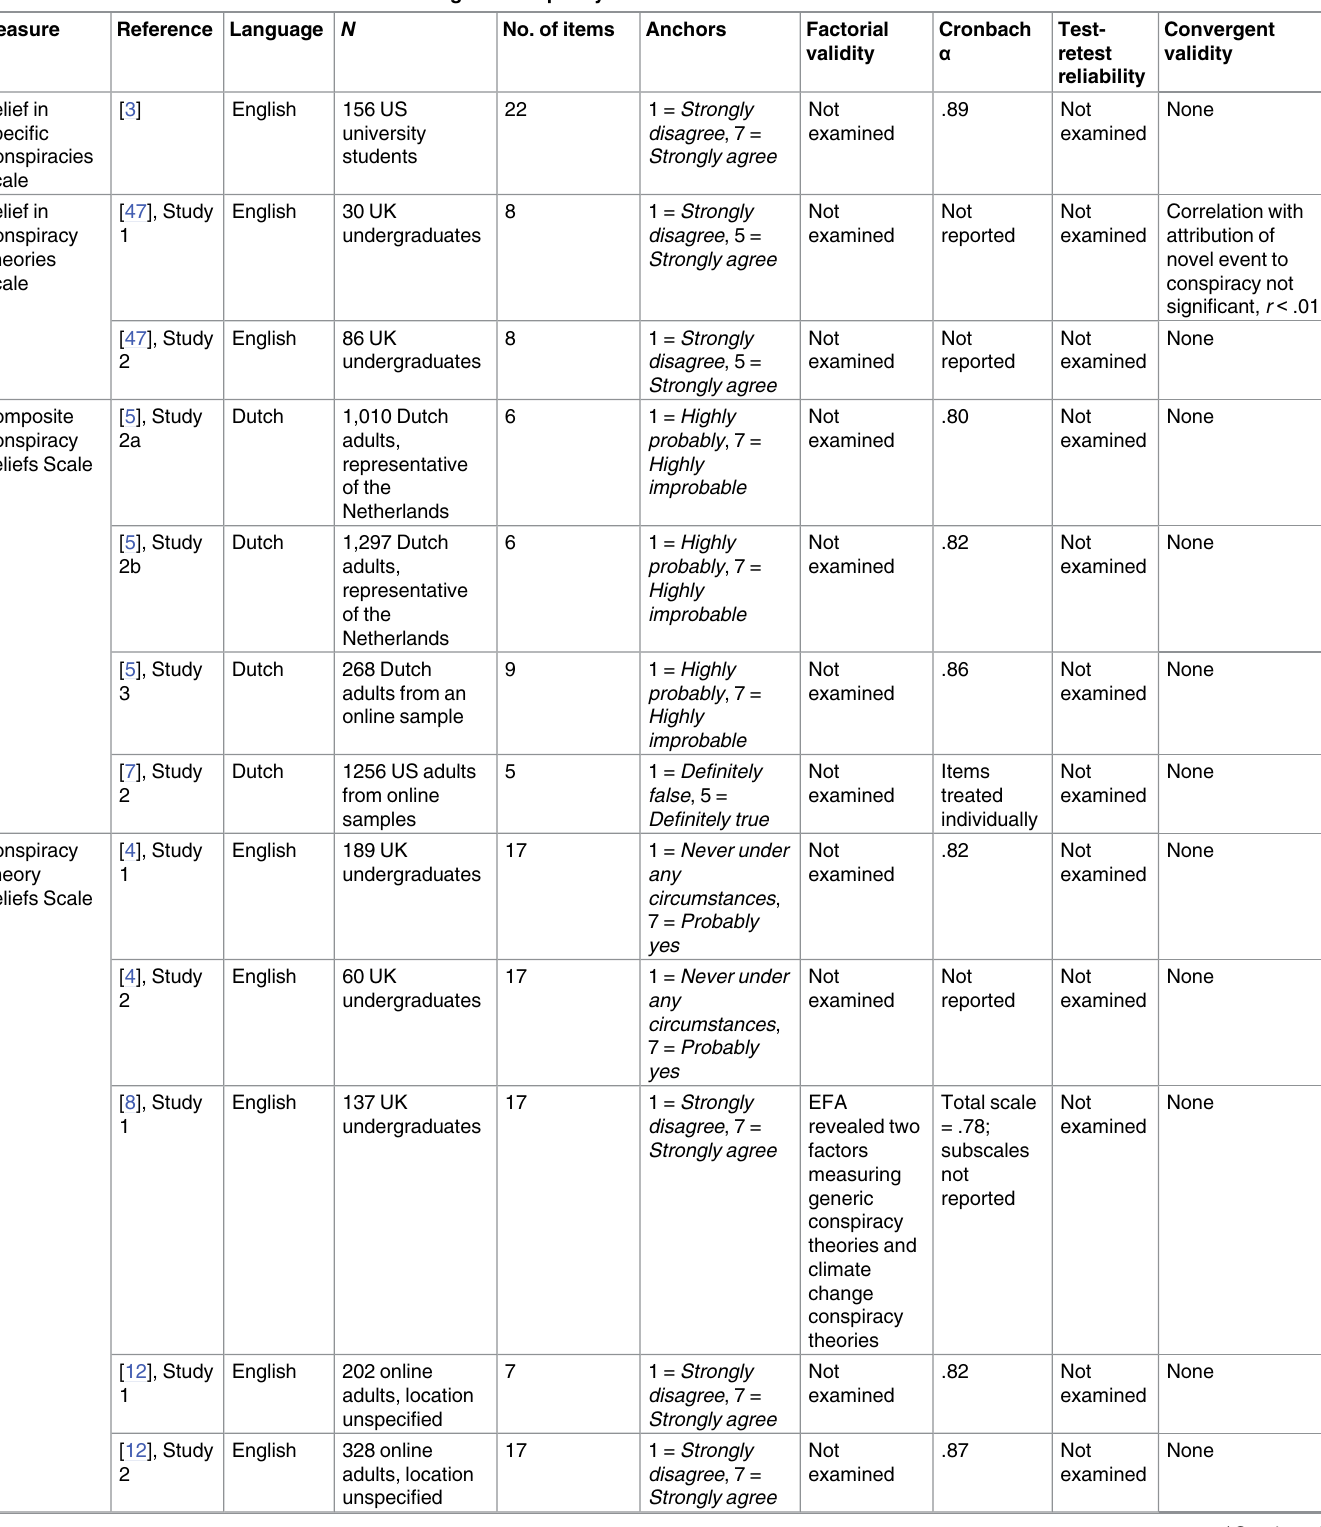
Table 1. Scales that measureendorsement of a range of conspiracy